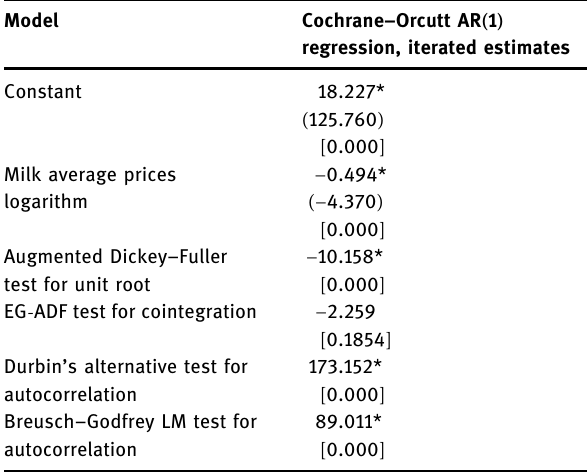
Table 3: Results for times series regression between the raw cows ’ milk delivered to dairies ( kilograms ) logarithm and the average prices ( euro/kg ) logarithm, for the months of the